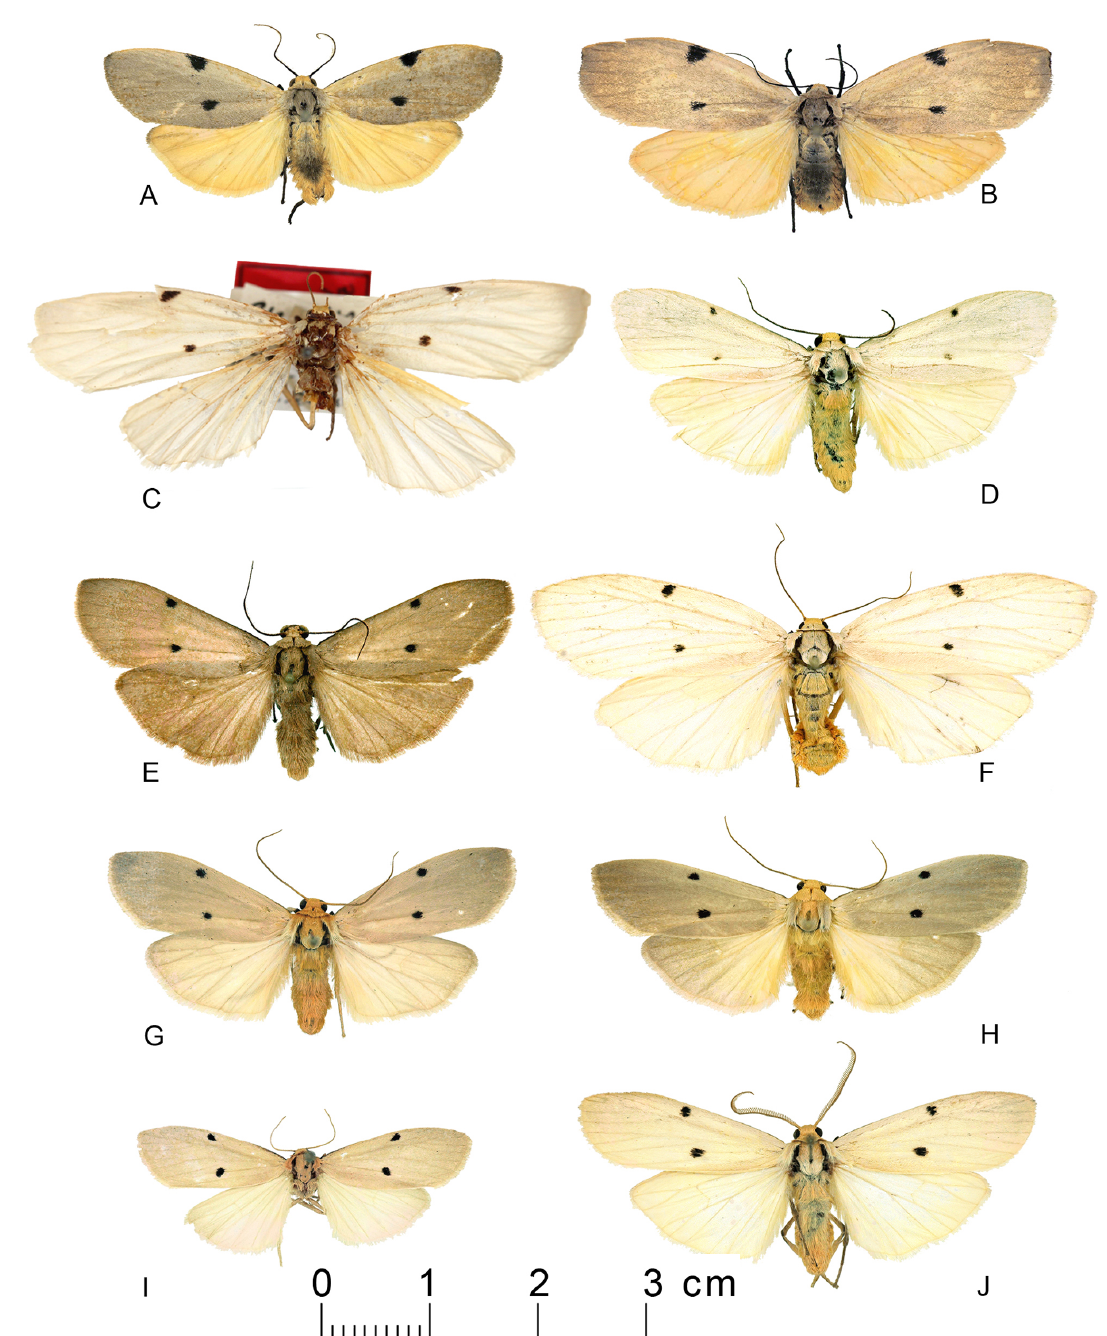
Fig. 3. Adults. A . Nanna ceratopygia Birket-Smith, 1965, ♂, Gabon, Makokou-Ipassa, 500 m, 0°30’43’’N 12°48’13’’E, 19 Feb.-11 Mar. 2011. B . Nanna ceratopygia , ♀ allotype. C . Nanna eningae (Plötz, 1880), ♀ holotype. D . Nanna eningae , ♂, Gabon, Makokou-Ipassa, 500 m, 0°30’43’’N 12°48’13’’E, 19 Feb.- 11 Mar. 2011, gen. prep. n. 697/12 MAD. E . Nanna eningae , ♂, Gabon, Makokou-Ipassa, 500 m, 0°30’43’’N 12°48’13’’E, 16-28 Feb. 2012, gen. prep. n. 705/12 MAD. F . Nanna eningae , ♀, Gabon, Makokou-Ipassa, 500 m, 0°30’43’’N 12°48’13’’E, 5-10 Apr. 2010. G . Nanna semigrisea sp. nov., ♂ paratype, gen. prep. n. 709/12 MAD. H . Nanna semigrisea sp. nov., ♂ paratype, gen. prep. n.